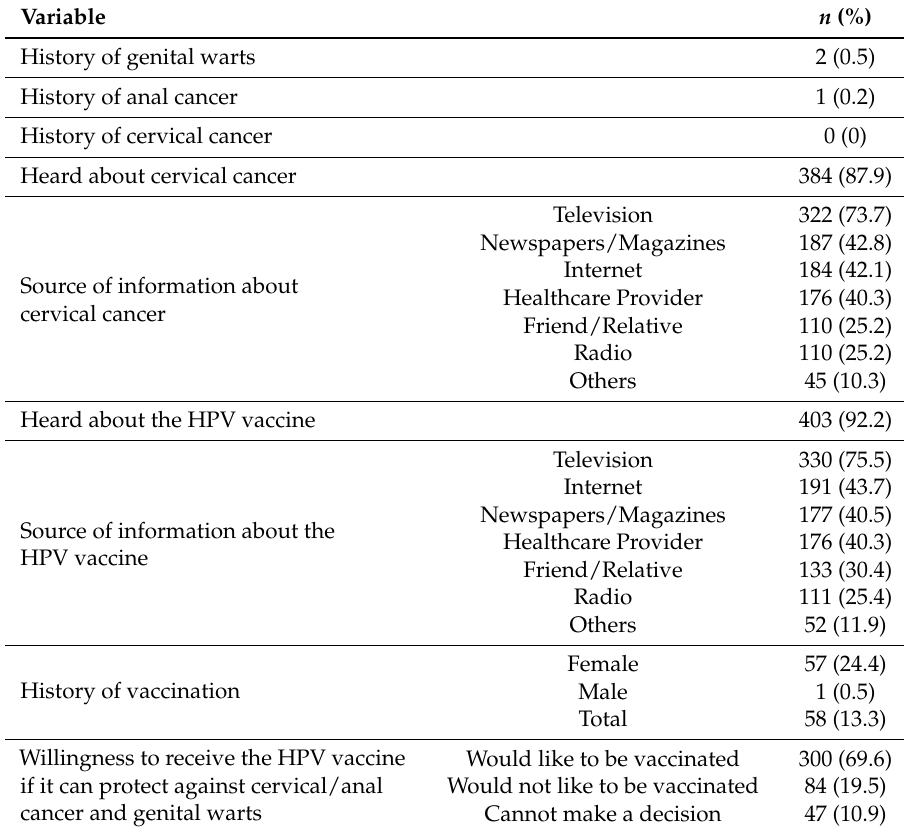
Table 2. Medical